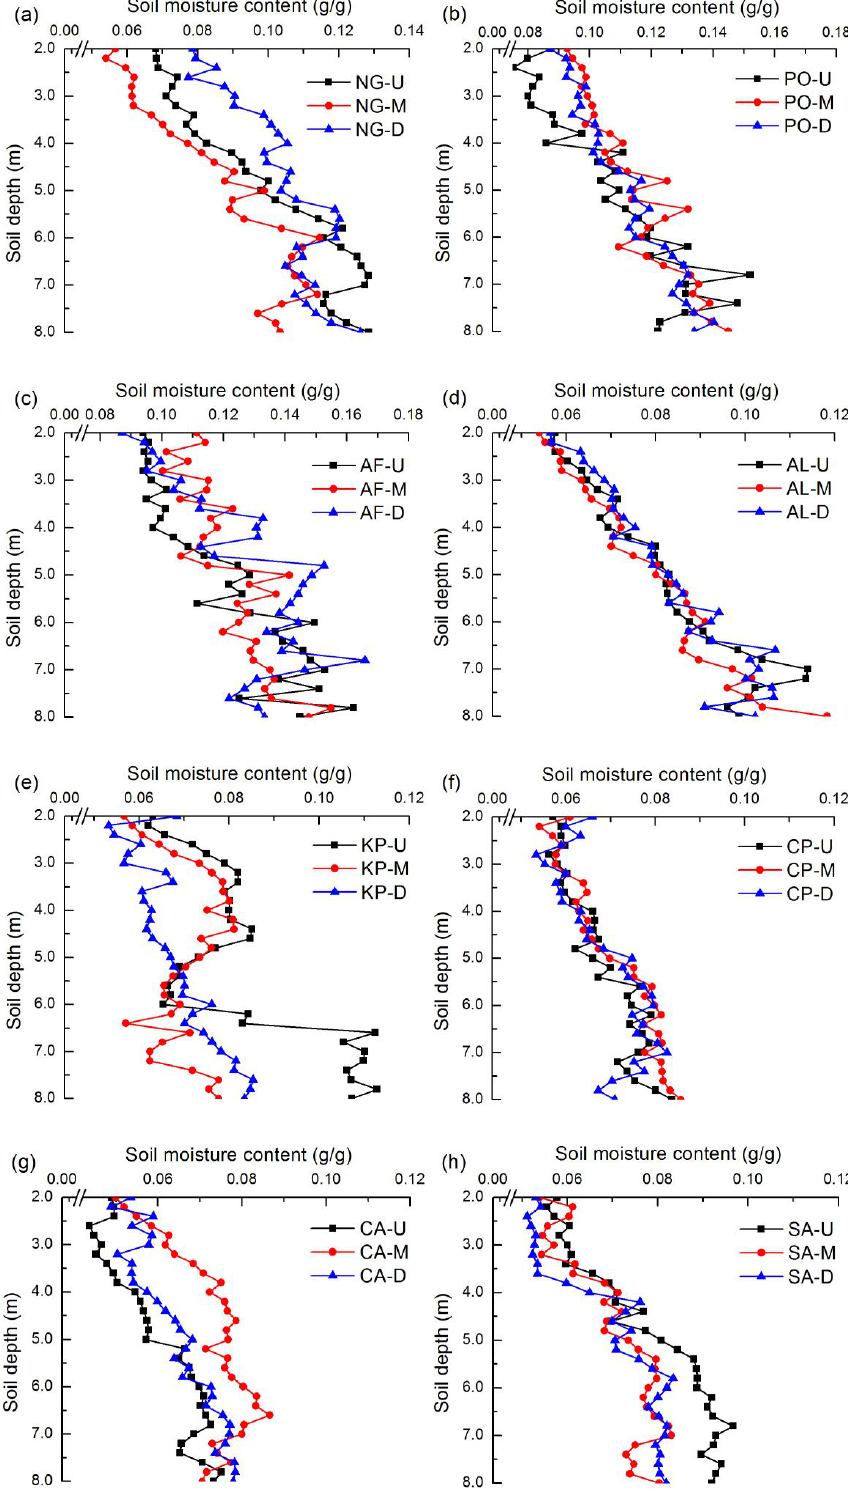
Fig. 3. Comparison of deep soil moisture content (SMC) on different slope positions. Note: NG represents native grassland; PO represents farmland planted with potato; AF represents abandoned farmland; AL represents alfalfa; KP represents korshinsk peashrub; CP represents Chinese red pine; CA represents Chinese arborvitae; SA represents Siberian apricot. The last letter U refers to upper position, M to middle position and D to downhill position. For example, NG-U, NG-M and NG-D refer to upper position of natural grassland, middle position of natural grassland and downhill position of natural grassland,